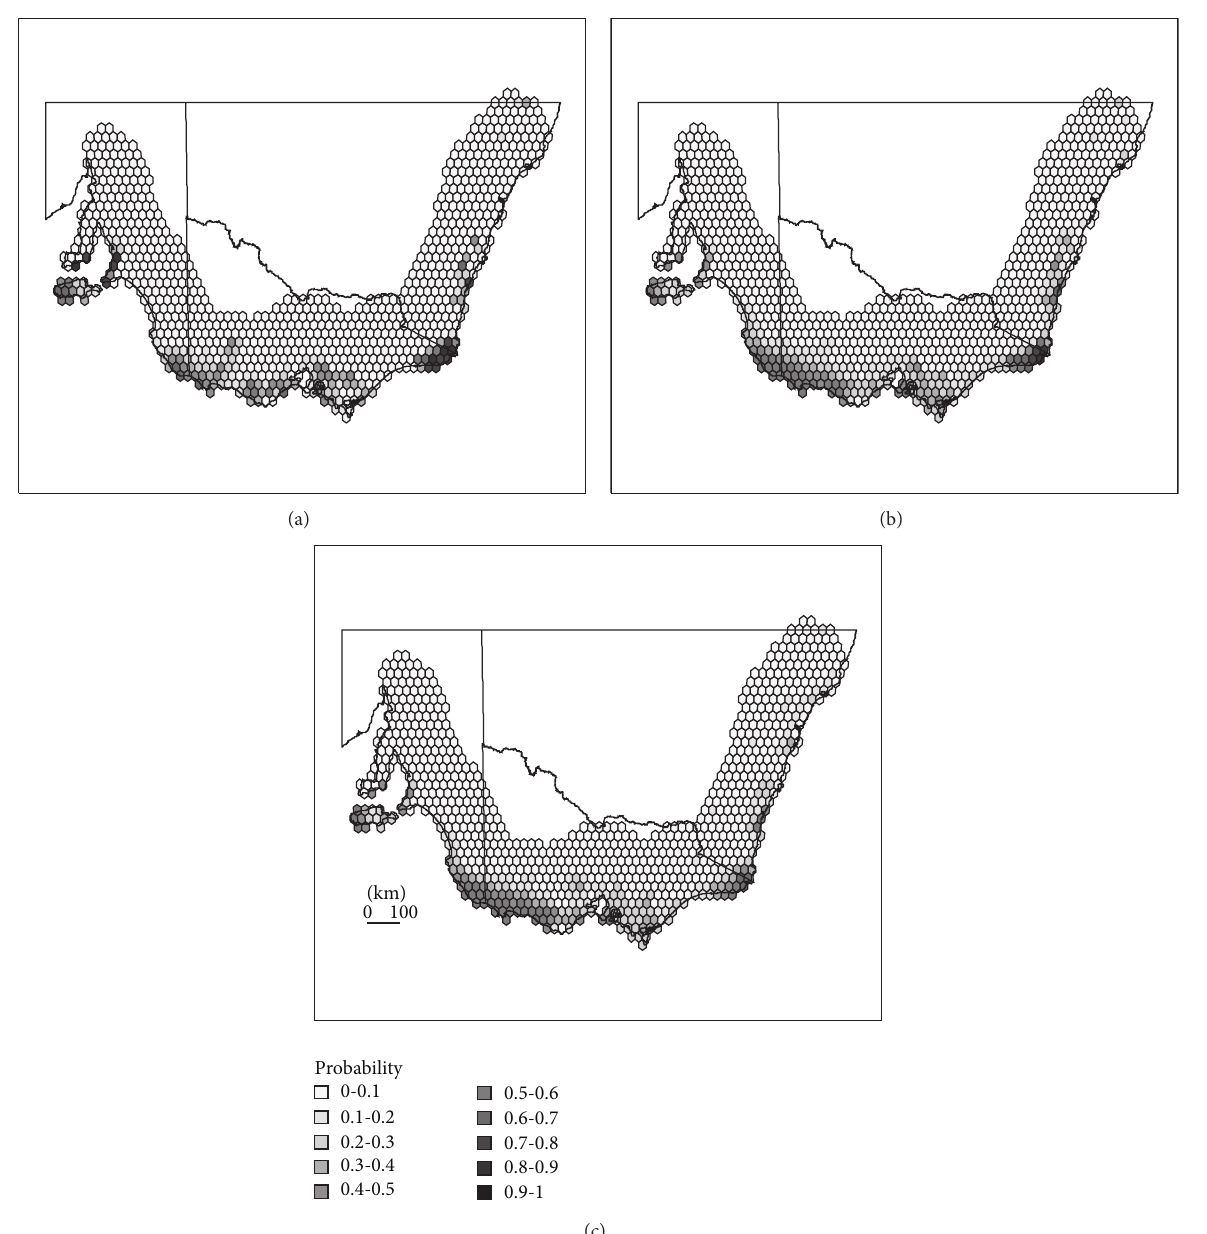
Figure 6: Spatial predictions of the distribution of Isoodon obesulus obesulus based on the probability estimates from generalized additive models, using (a) six variables, (b) four variables, and (c) three